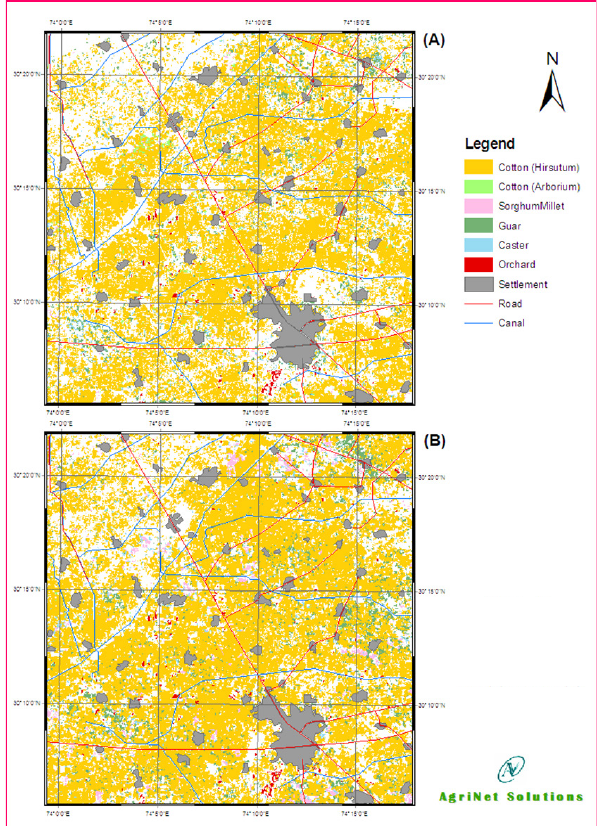
Figure-5. Crop maps for 2004 (A) and 2008 (B) of Firozpur district, Punjab